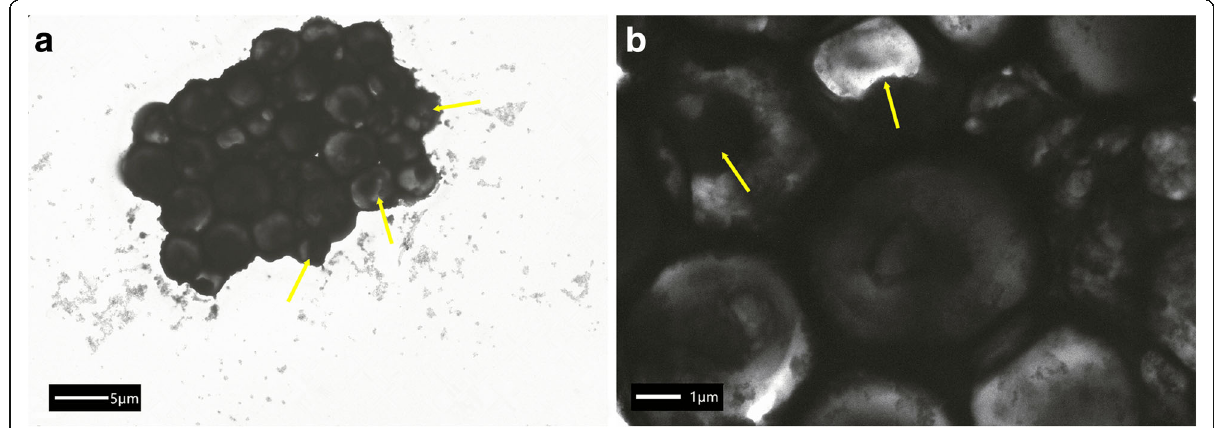
Fig. 8 a , b TEM images demonstrate photo-thermal damages of C. neoformans cells that were conjuncted with GNR-SiO 2 -Ab. The cells displayed atrophic, irregular, and collapsed appearances. The characteristic polysaccharide capsule was